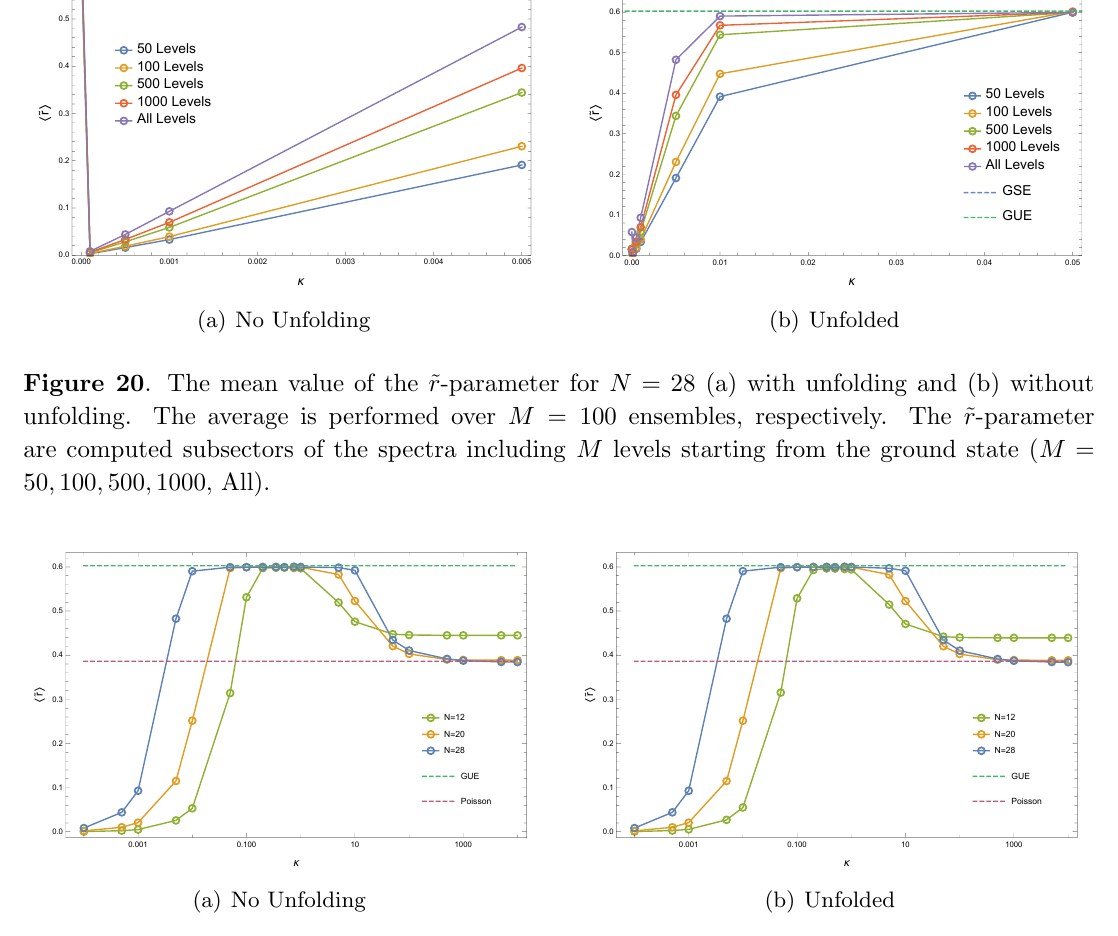
Figure 21 . The mean value of the ~ r -parameter for N = 12 ; 20 ; 28 (cid:17) 4 (mod8) of (a) the spectrum without unfolding (b) the unfolded spectrum. The average is performed over M = 4000 ; 500 ; 100 ensembles, respectively. We observe a transition from GUE to